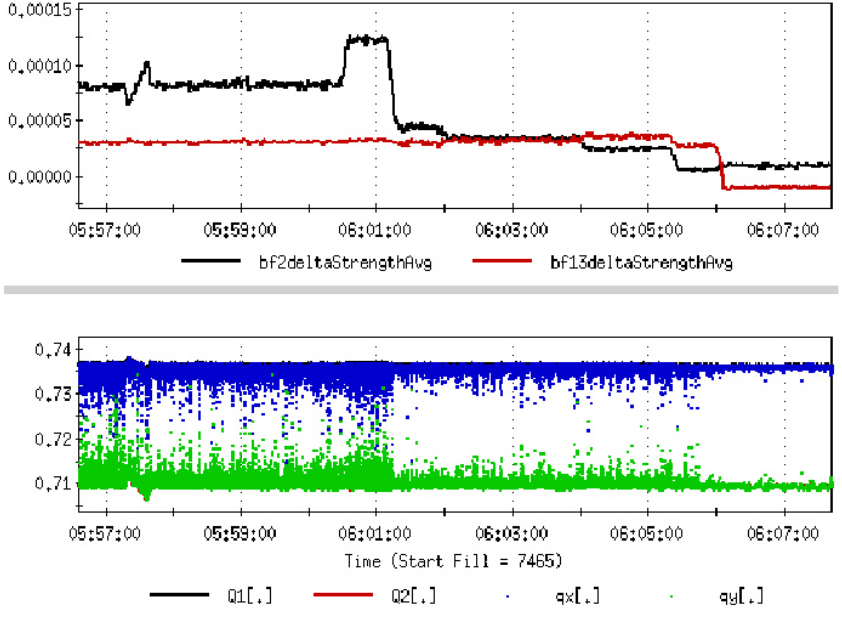
FIG. 10. (Color) Manual